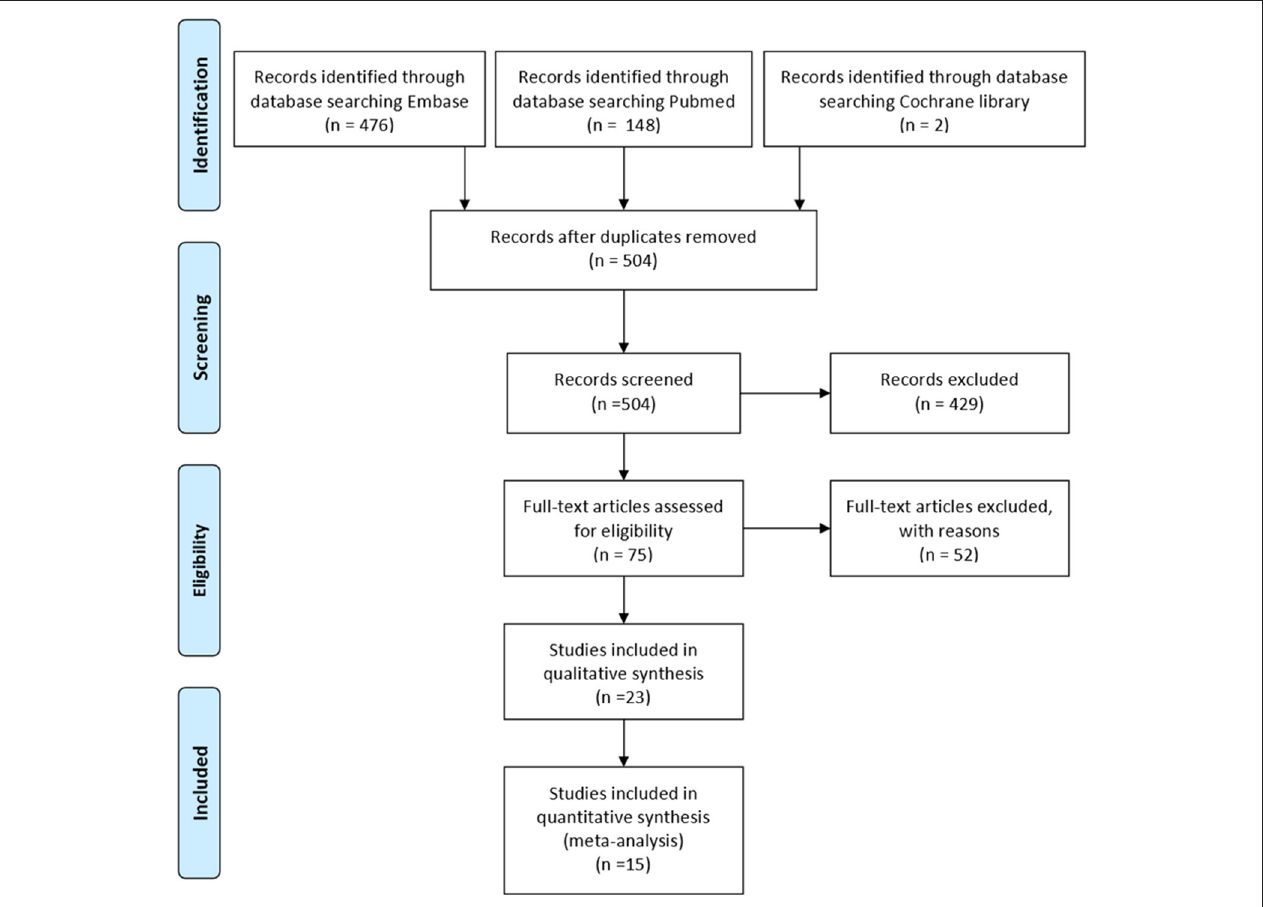
FIGURE 1 | The preferred reporting items for systematic reviews and meta-analyses (PRISMA) flow chart of studies selection.